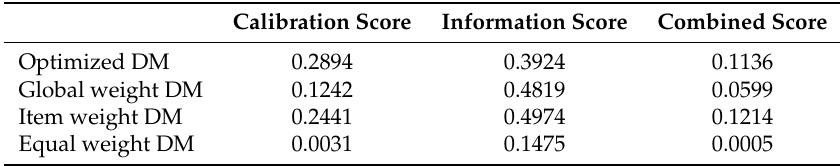
Table 3. Performance of the different Decision Makers for panel 2.